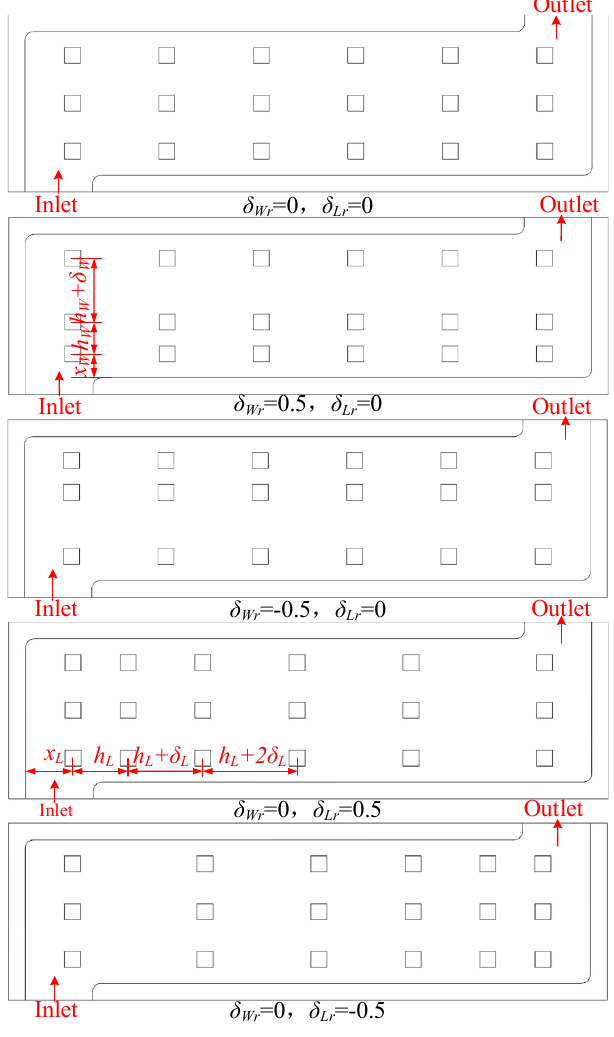
Figure 13. Cooling plate with different distributions of pin-fins.